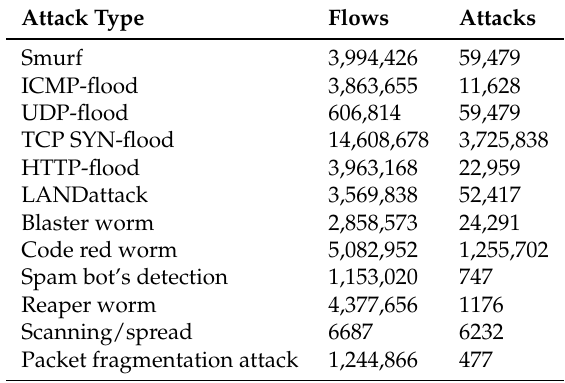
Table 6. Sample counts for the type of attacks, number of flows, and number of attacks in the